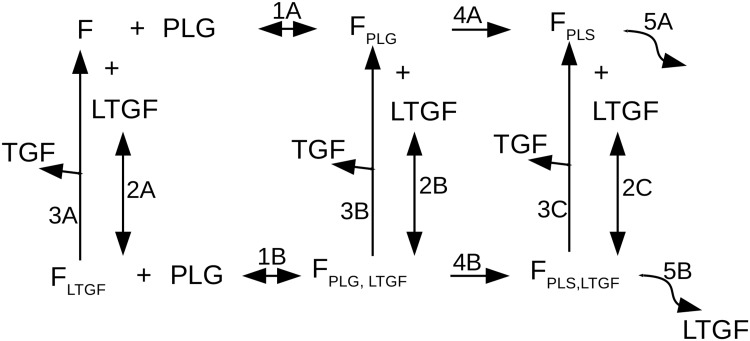
Overview of the binding and conversion reactions of plasminogen and latent-TGFβ1 in relation to fibrin.Plasminogen (PLG) and latent-TGFβ1 (LTGF) do not compete for binding with fibrin, thus fibrin can be unbound (F), bound solely by plasminogen (FPLG), bound by solely latent-TGFβ1 (FLTGF), or by both (FPLG,LTGF). Plasminogen reversible binds fibrin (reactions 1A and 1B). Latent-TGFβ1 also reversible binds fibrin (reactions 2A, 2B, and 2C). Latent-TGFβ1 is released from fibrin by plasmin into the active form (TGF, reactions 3A, 3B, and 3C). Fibrin-bound plasminogen can be converted to fibrin-bound plasmin, either without (FPLS, reaction 4A) or with (FPLS, LTGF, reaction 4B) co-binding of latent-TGFβ1. Reactions 5A and 5B represent fibrinolysis, which can result in the release of latent-TGFβ1 (reaction 5B).